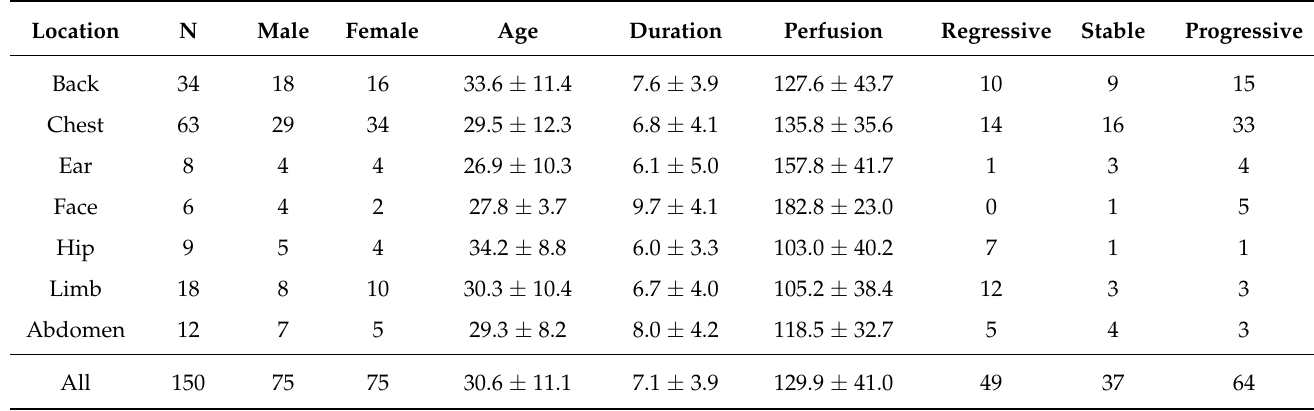
Table 1. Demographic